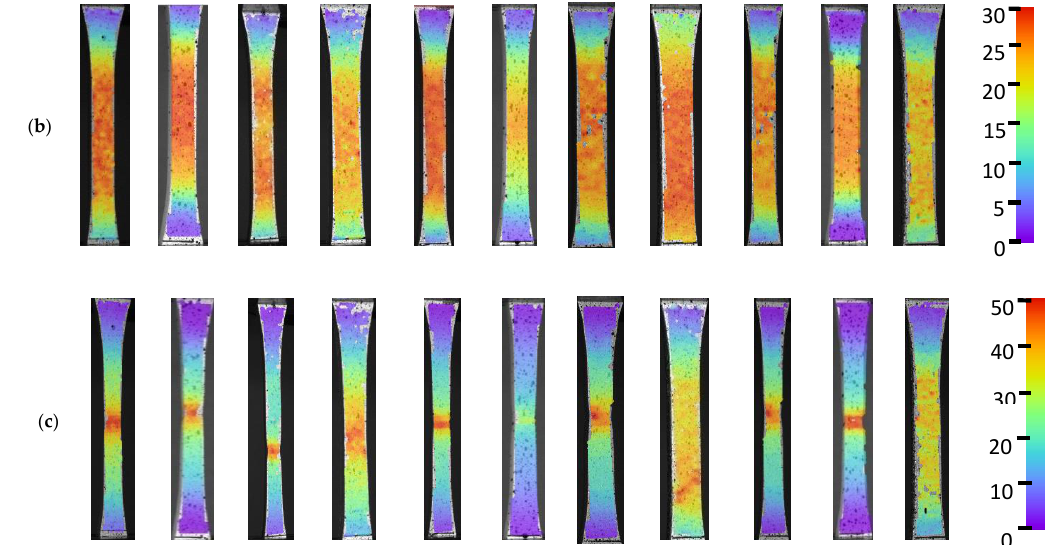
Figure 5. Strain distribution during monotonic tensile tests: ( a ) yield strength, ( b ) ultimate tensile